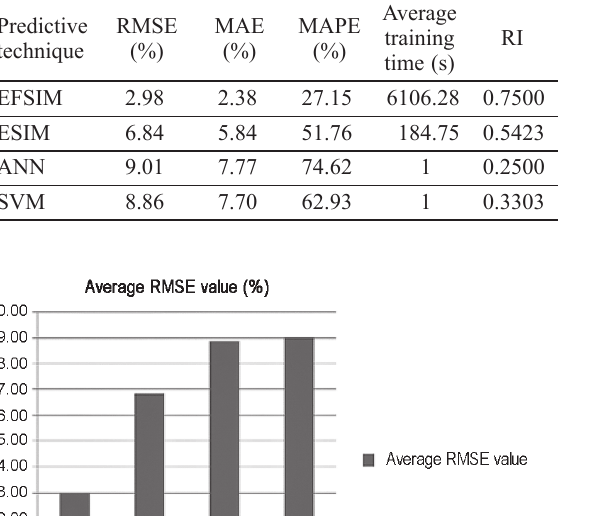
Table 6. Average performance values of the predictive techniques Predictive technique